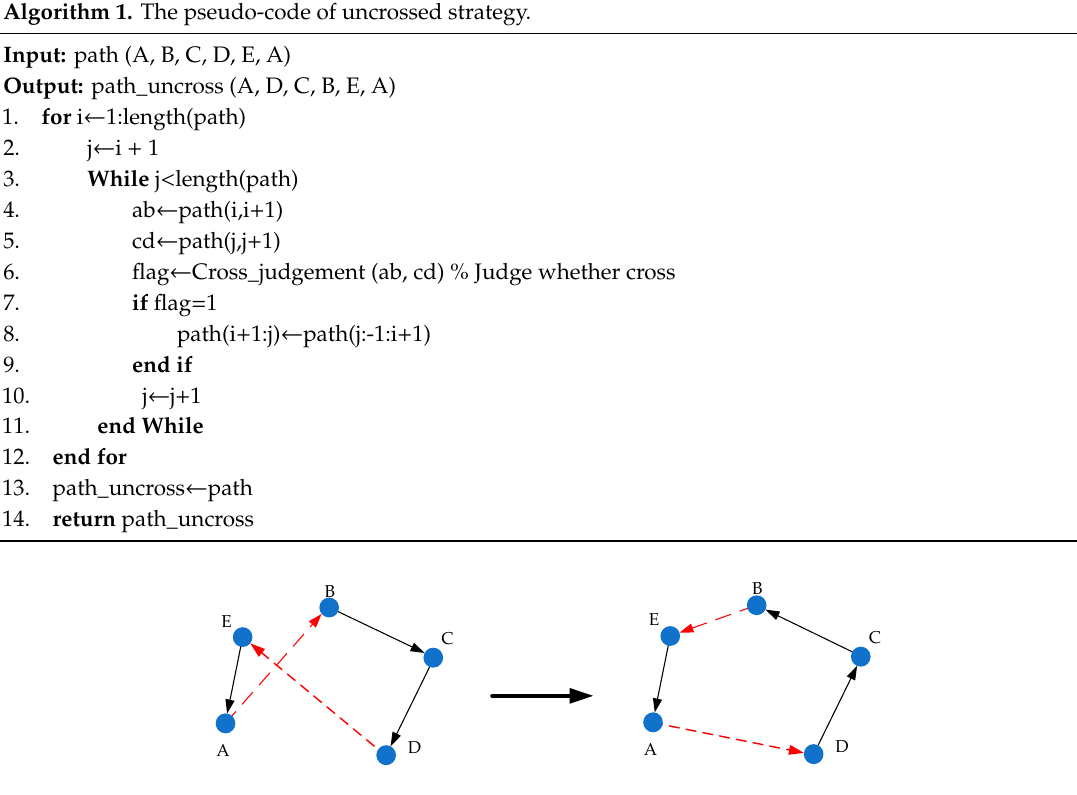
Figure 1. Schematic diagram of uncrossed strategy. Algorithm 1. The pseudo-code of uncrossed strategy.